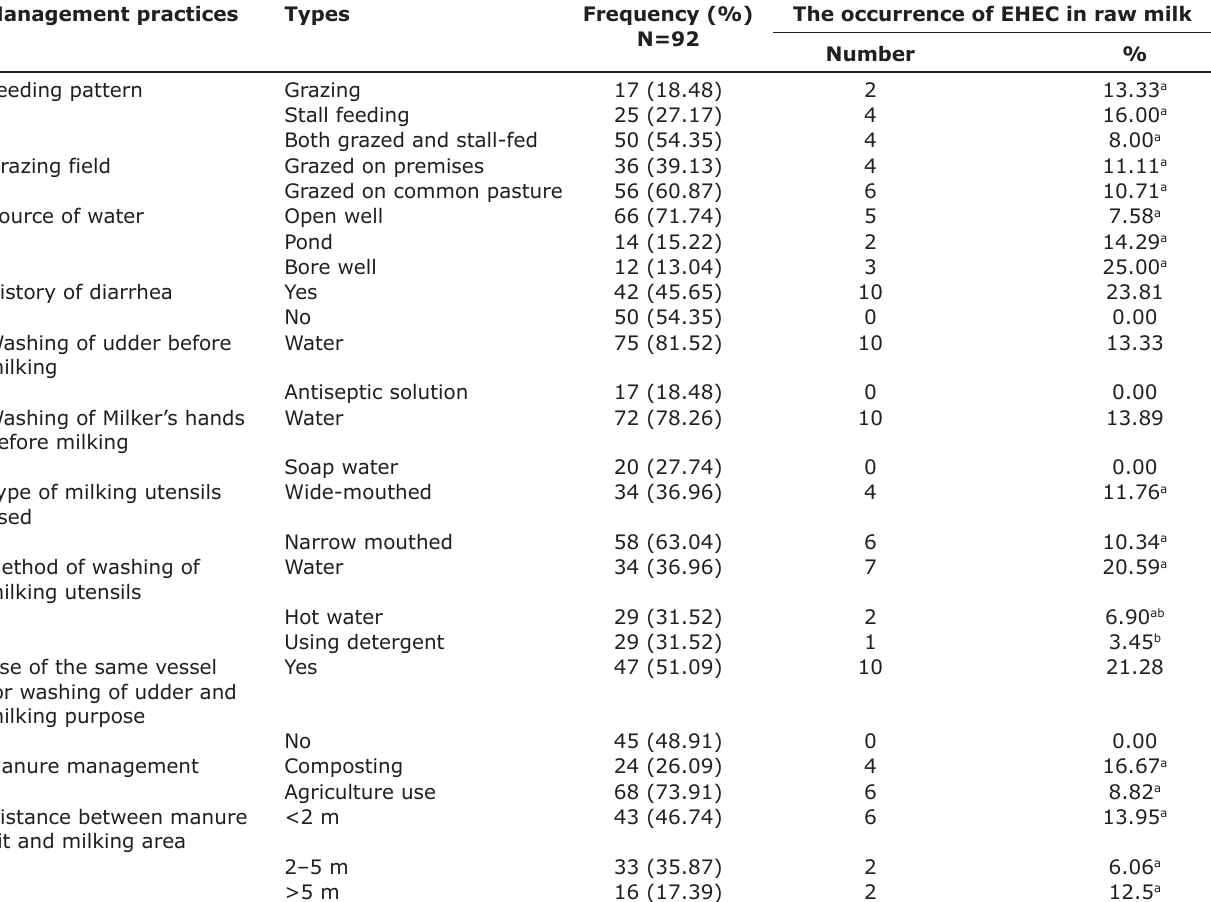
Table-4: Association of various risk factors involved in milking management practices with the occurrence of EHEC in raw milk. Management